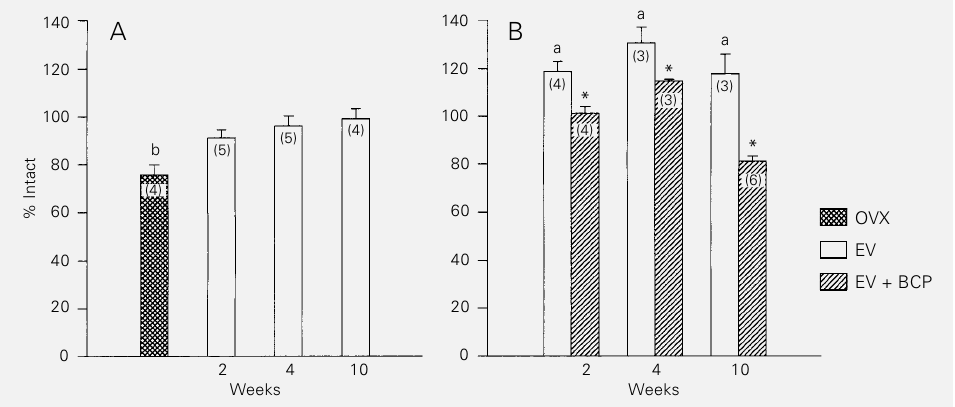
Figure 1 - Effects of estradiol valerate alone or in combination with bromocriptine on the per- cent of immunoreactive prolac- tin cells in ovariectomized rats. Data are reported as percent of prolactin immunopositive cells in relation to those observed in intact rats (mean – SEM). The number of animals is given in parentheses. A , Rats were in- jected with vehicle (OVX) or es- tradiol valerate (EV) (50 (cid:181)g rat -1 week -1 ) for 2, 4 or 10 weeks. B , Rats were injected with EV (300 (cid:181)g rat -1 week -1 ) for 2, 4 or 10 weeks. EV + BCP, EV (300 (cid:181)g rat -1 week -1 ) plus bromocriptine (0.6 mg rat -1 day -1 ), during the last 12 days of estrogen treat- ment. a P<0.05 compared to in- tact rats (Duncan(cid:146)s test); *P<0.05 compared to EV (300 (cid:181)g rat -1 week -1 ) ( t -test). b P<0.05 compared to EV (50 and 300 (cid:181)g rat -1 week -1 ) and EV + BCP groups (Duncan(cid:146)s